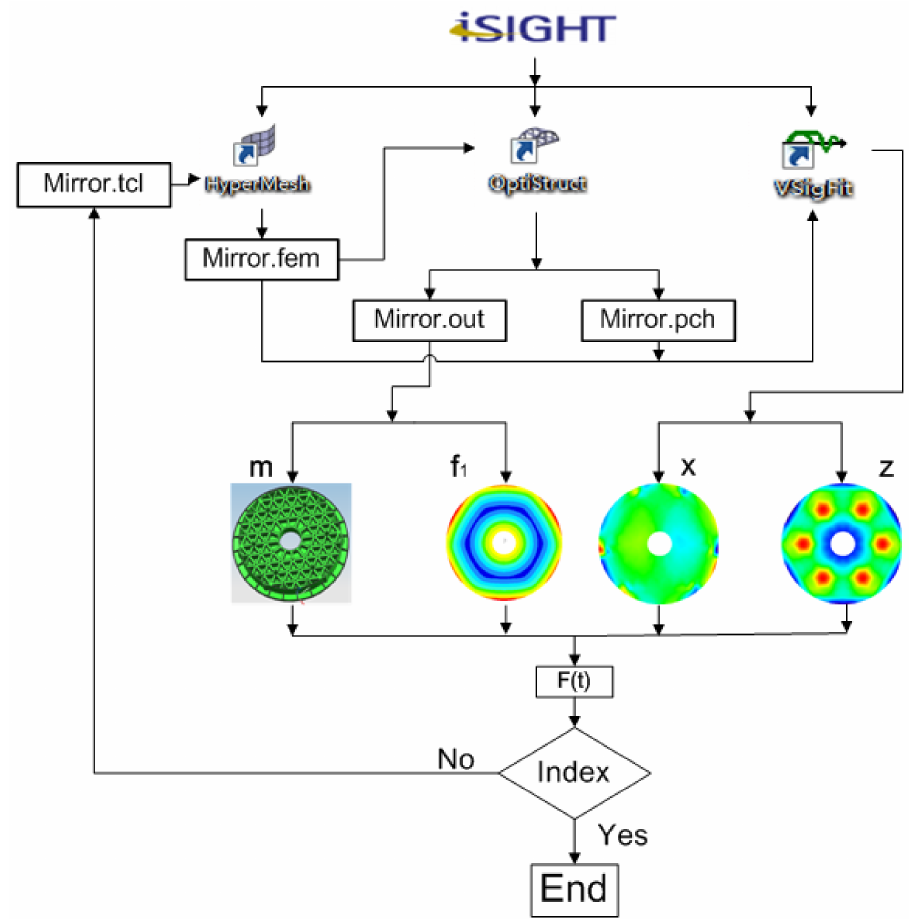
Figure 7. Flow chart of the parametric design of the primary mirror. Parametric design mathematical